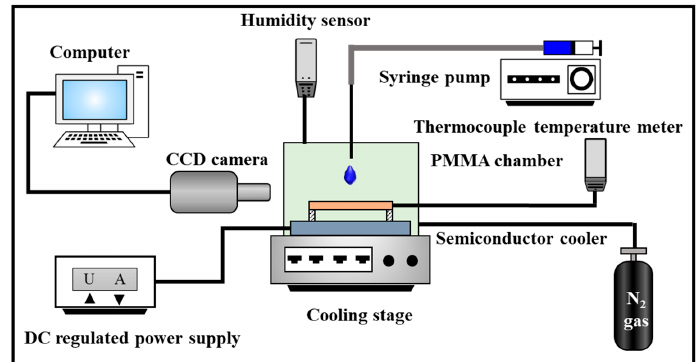
Figure 2. Experimental setup of droplet impacting on the cold elastic superhydrophobic membrane.